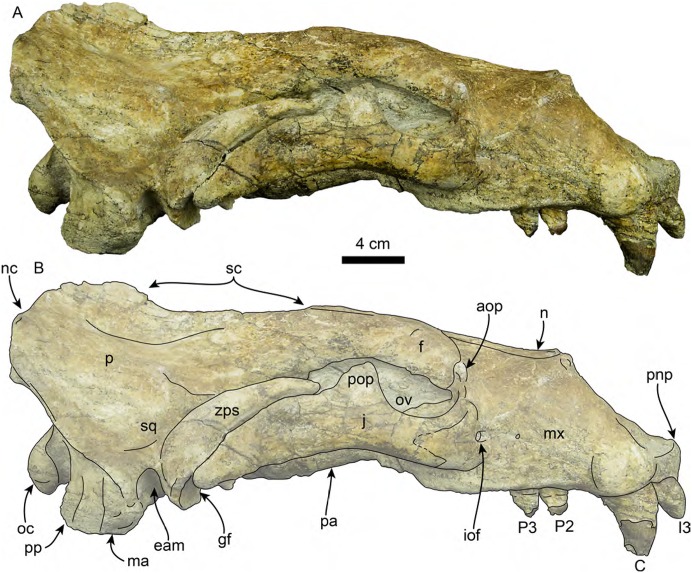
Skull of Titanotaria orangensis n. gen. et sp. (OCPC 11141).Skull in right lateral view, without labels (A) and labelled (B). Abbreviations: aop, antorbital process; C, upper canine; eam external auditory meatus; f, frontal; gf, glenoid fossa; I3, third upper incisor; iof, infraorbital foramen; j, jugal; ma, mastoid; mx, maxilla; n, nasal; nc, nuchal crest; oc, occipital condyle; ov, orbital vacuity; P2–3, upper premolars 2–3; p, parietal; pa, palatine; pnp, prenarial process; pop, postorbital process; pp, paroccipital process; sc, sagittal crest; sq, squamosal; zps, zygomatic process of squamosal.